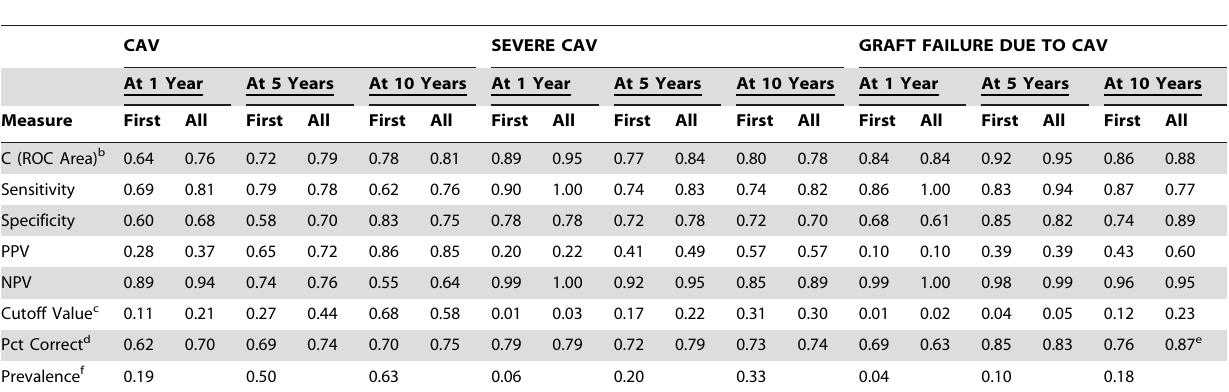
Table 6. Performance characteristics for first-biopsy (First) and three-month (All) biopsy models. a